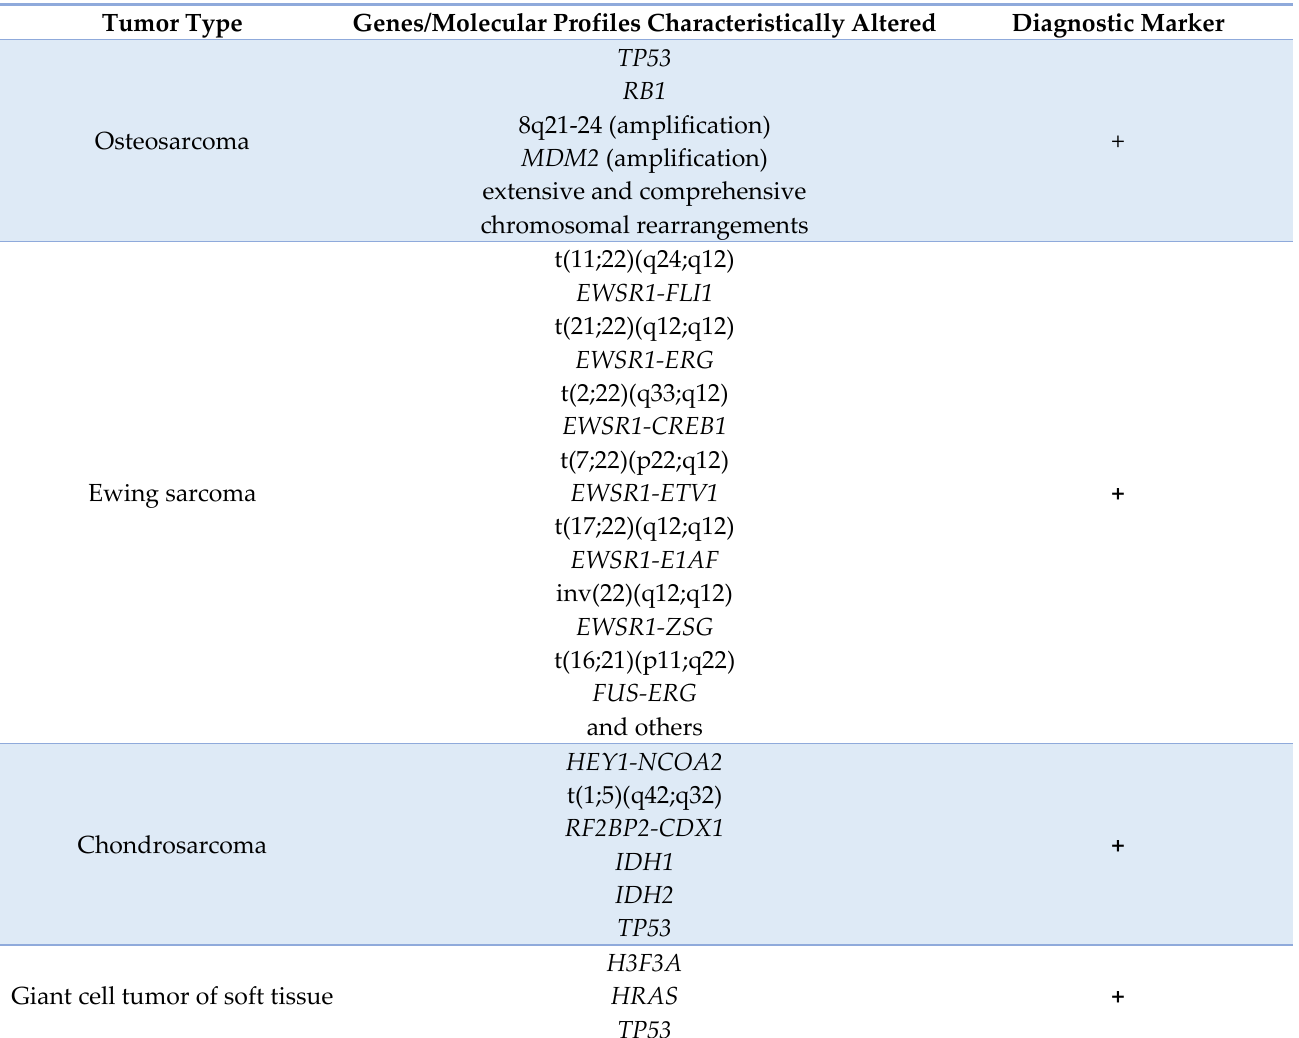
Table 4. Molecular markers—malignant bone tumors.